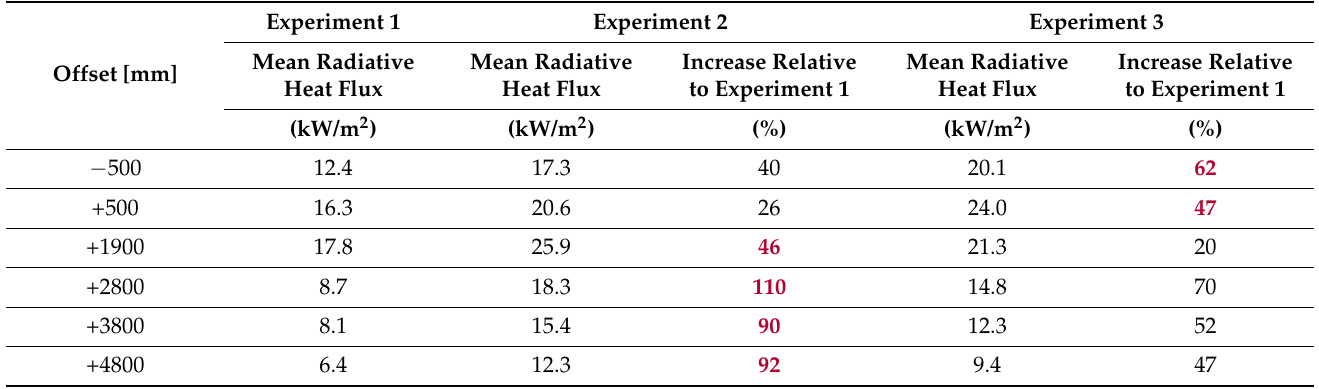
Table 2. Mean radiative heat flux to floor by offset from burner array and percentage increase rela- tive to Experiment 1 (burner array HRR = 1250 kW). Red values indicate largest increase relative to Experiment 1 for the exposed CLT cases.